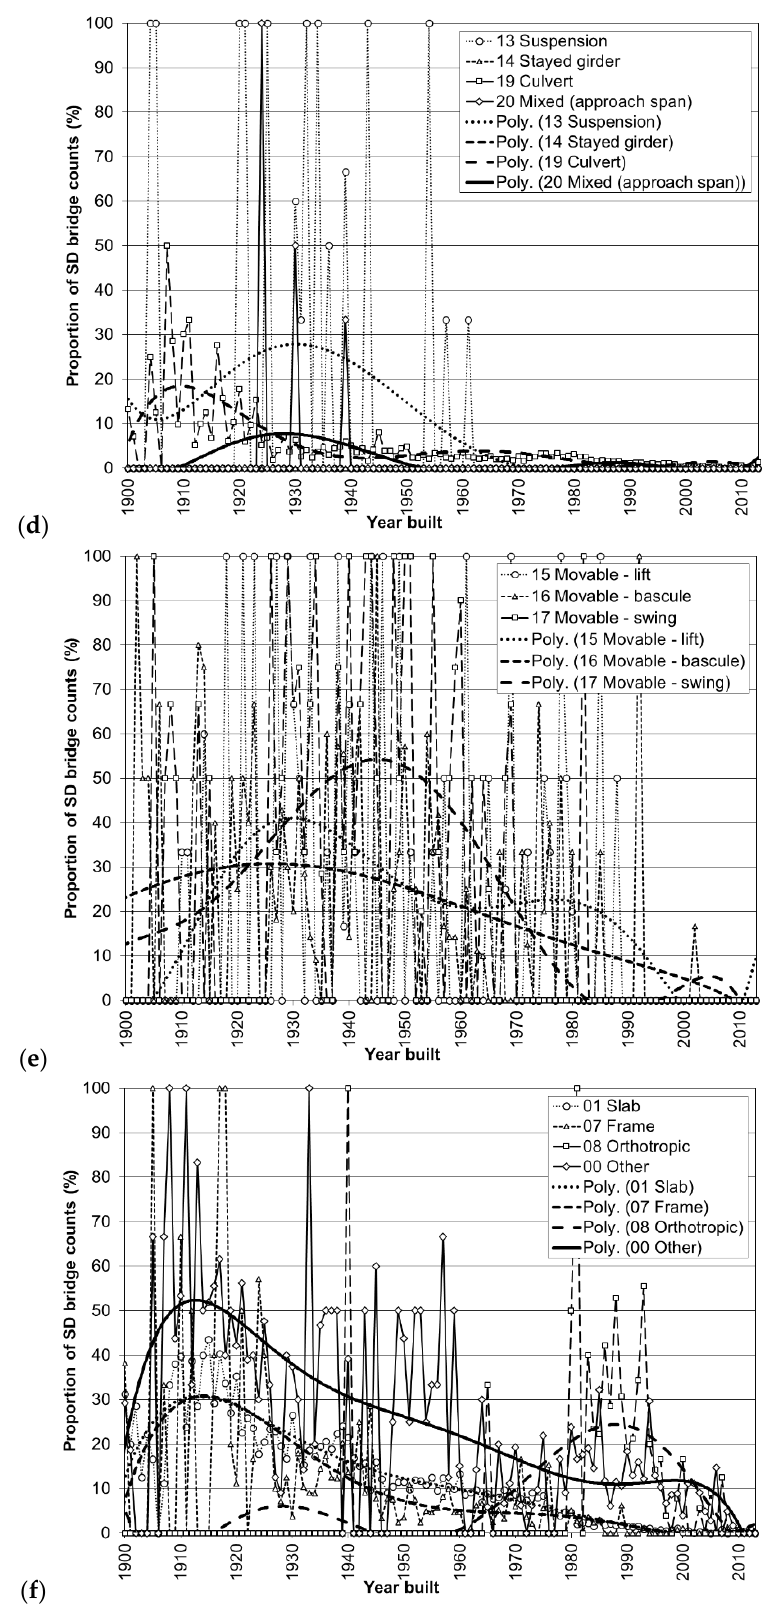
Figure 11. Distribution of the proportion of SD bridge counts by type. ( a ) Beam; ( b ) Box; ( c ) Truss and arch; ( d ) Suspension, stayed girder, culvert, and mixed; ( e ) Movable and tunnels; ( f ) Slab, frame, orthotropic, and other.